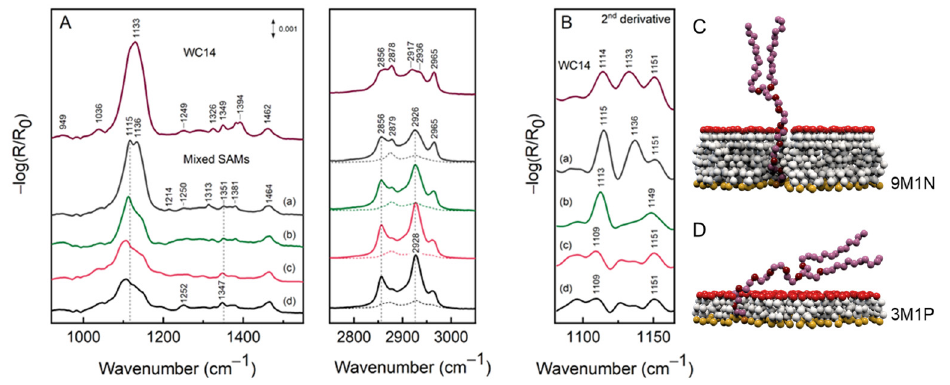
Figure 5. ( A ) RAIRS spectra of Ag adsorbed WC14 (top curve) and mixed SAMs containing different backfillers in the following order: 9M1N (a), 6M1H (b), 4M1B (c), 3M1P, (d) in the 900–1600 and 2750–3050 cm –1 range. The composition of mixed SAMs was 80% backfiller and 20% WC14. Dashed curves in C–H stretching region represent one-component monolayers that had, on average, a 5-times lower area under the curve than the corresponding mixed SAMs. ( B ) The second derivative RAIRS spectra in ν as (C–O–C) region (multiplied by − 1). The arrangement of the spectra corresponded to that of the ( A ) panel. Panels ( C , D )—proposed model of WC14 molecules orientation on Ag surface (at air/solid interface): ( C ) WC14 diluted with 9M1N in ratio 20:80% WC14/3M1P; ( D ) WC14 diluted with 3M1P in ratio 20:80% WC14/9M1N.